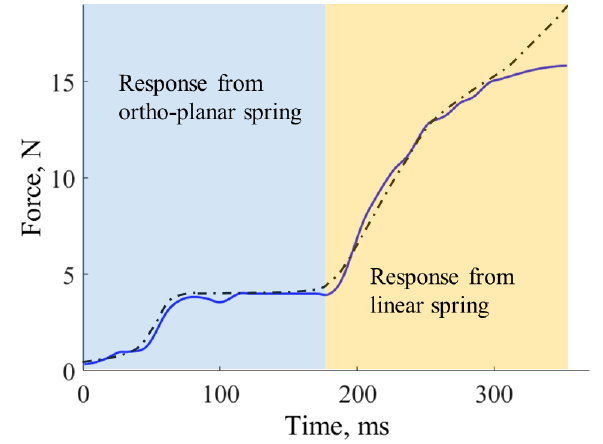
Figure 13. Force measurements from the fingertip sensor and force and torque